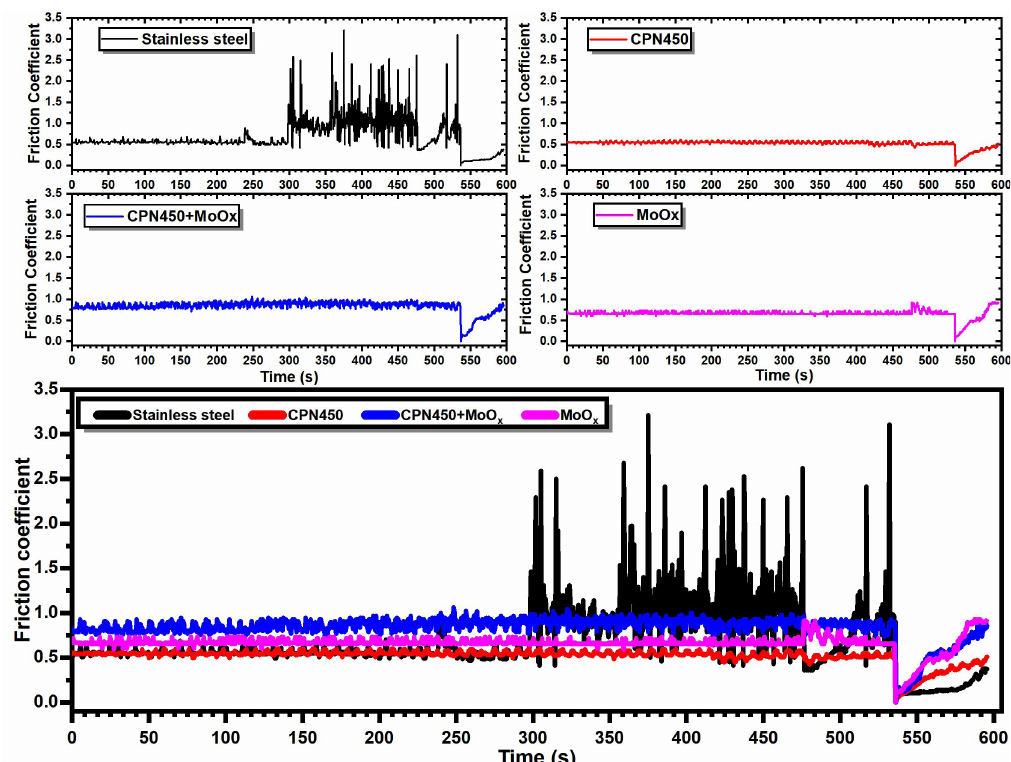
Figure 6. Friction coefficients of the